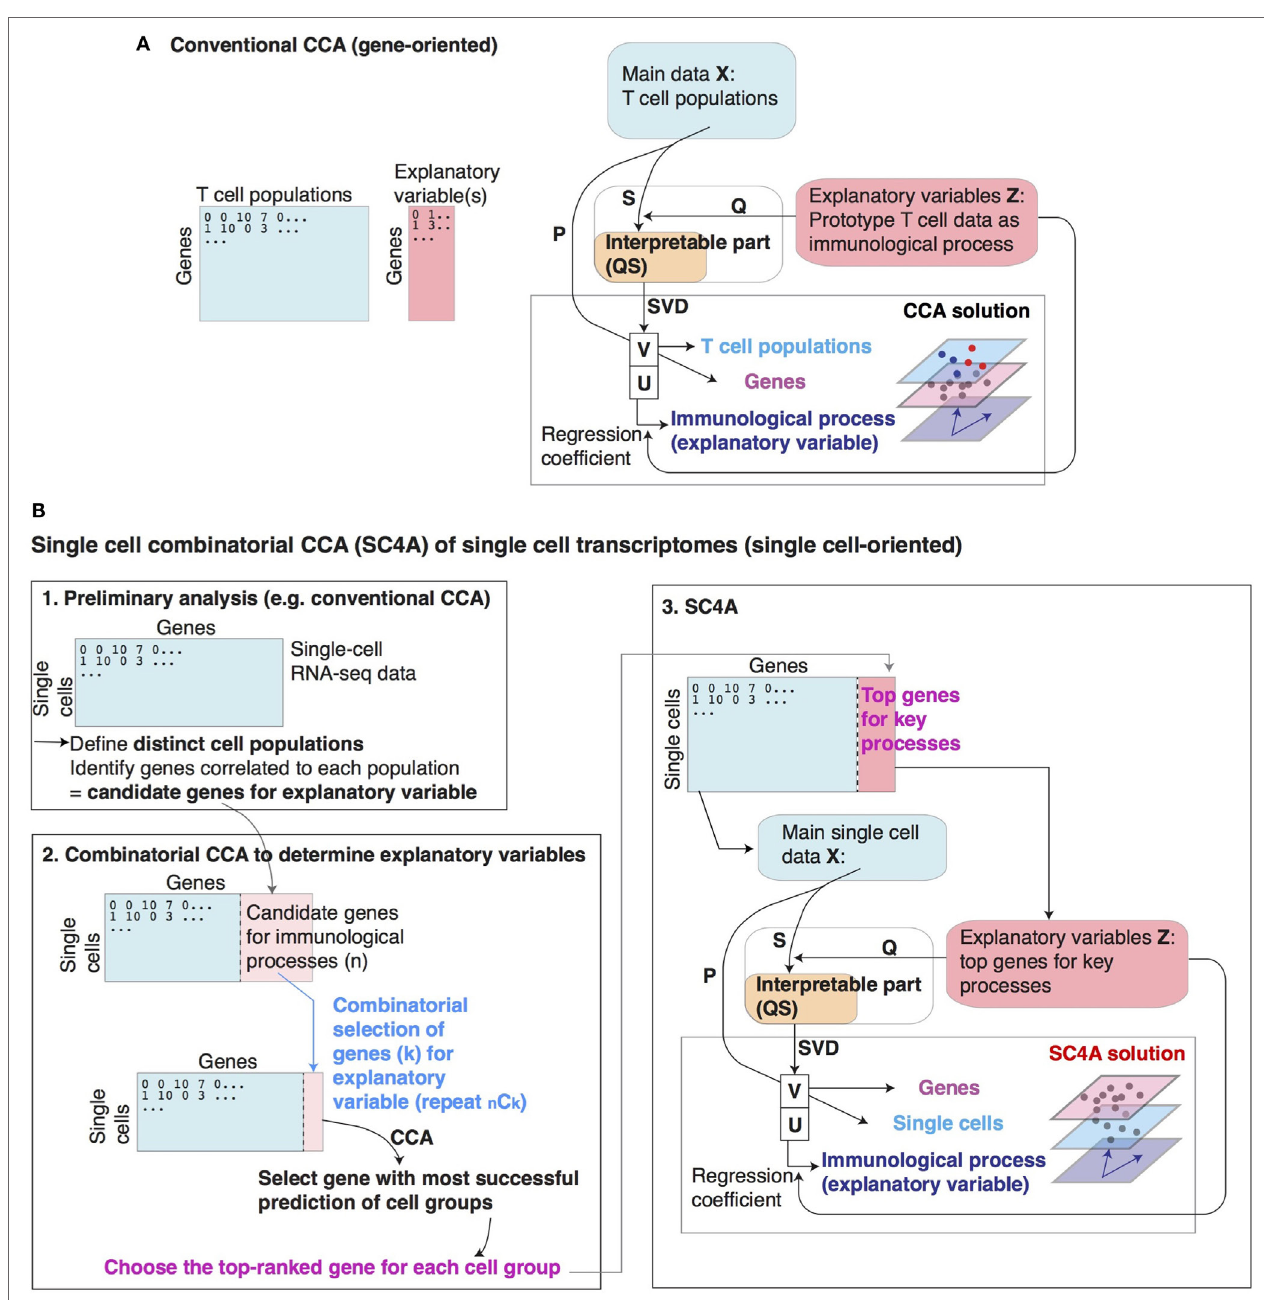
FigUre 1 | Conventional canonical correspondence analysis (CCA) and single-cell combinatorial CCA (SC4A). (a) Schematic representation of conventional CCA for the cross-level analysis of T cell populations (cells), immunological processes, and genes. (B) Overview of SC4A. Individual key genes are selected to represent processes of interest (differentiation/activation) and used as explanatory variables. CCA is performed to visualize the relationship between these key genes, single-cell samples, and all other genes in the single-cell samples. (1) Preliminary analysis by conventional CCA to identify correlations of single cells with genes representing differentiation/activation processes. (2) Procedures in combinatorial CCA to identify combinations of key top-ranked genes that represent the entire biological process of interest (differentiation/activation) as explanatory variables. (3) The final output of SC4A solution. Single-cell samples are analyzed by conventional CCA using top-ranked genes by the combinatorial CCA. The solution is visualized to model the entire single-cell transcriptomes for the biological processes of interest.